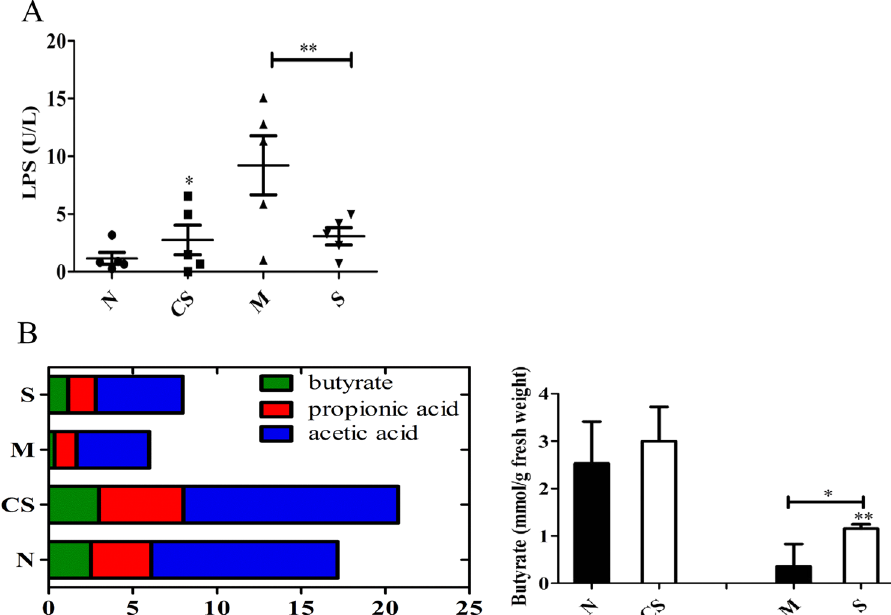
Figure 4. Blood lipopolysaccharides (LPS) and fecal short-chain fatty acid (SCFA) levels. ( A ) Blood LPS; ( B ) total SCFA and butyrate concentrations. N: healthy mice + PBS; CS: healthy mice supplemented with a daily dose of 150 mg/kg bodyweight of CS disaccharides for 16 days; M: mice subjected to exhaustive exercise stress + PBS; S: the stressed mice supplemented with a daily dose of 150 mg/kg bodyweight of CS disaccharides for 16 days. * P < 0.05; ** P < 0.01.